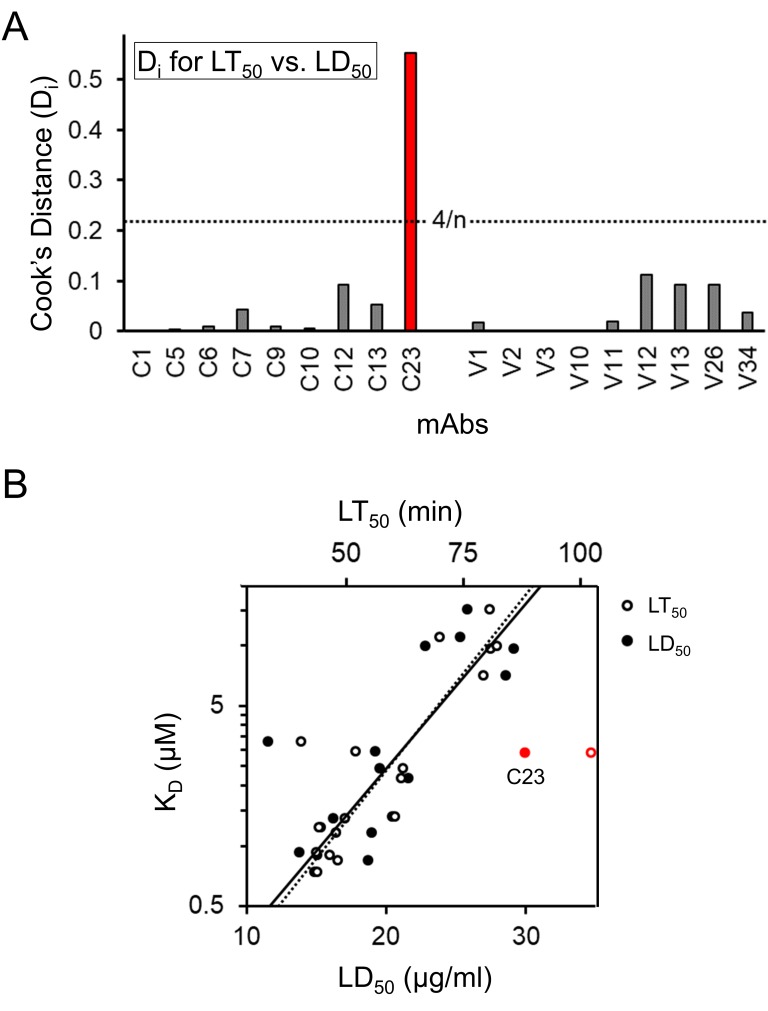
Comparison of bactericidal activity values, LT50 and LD50.(A) The Cook’s Distance (Di) was determined for the linear correlation of LT50 and LD50 (R2 = 0.867). C23 (red) was the only mAb with a Di value above the outlier threshold. (B) Plots of KD vs. LD50 and KD vs. LT50 are overlaid and centered on fits with C12 and C23 removed (solid line: LD50R2 = 0.773, dashed line: LT50R2 = 0.872). The LT50 value of C23 (open red) is shifted farther away from the expected value than the LD50 value of C23 (solid red).